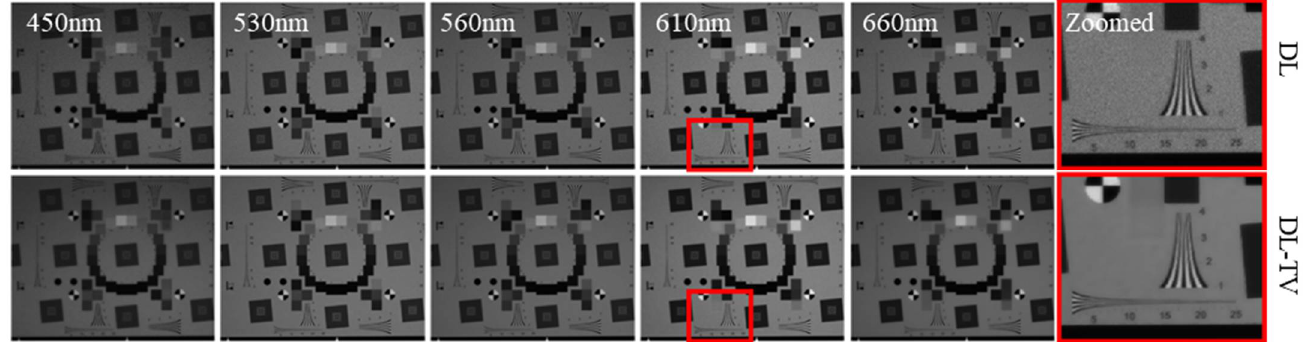
Figure 7. Comparison between the hyperspectral images reconstructed using the DL and DL-TV algorithms of the proposed system for the target image in the 450, 530, 560, 610, and 660 nm bands. Zoomed-in images for the 660 nm band are displayed as well.